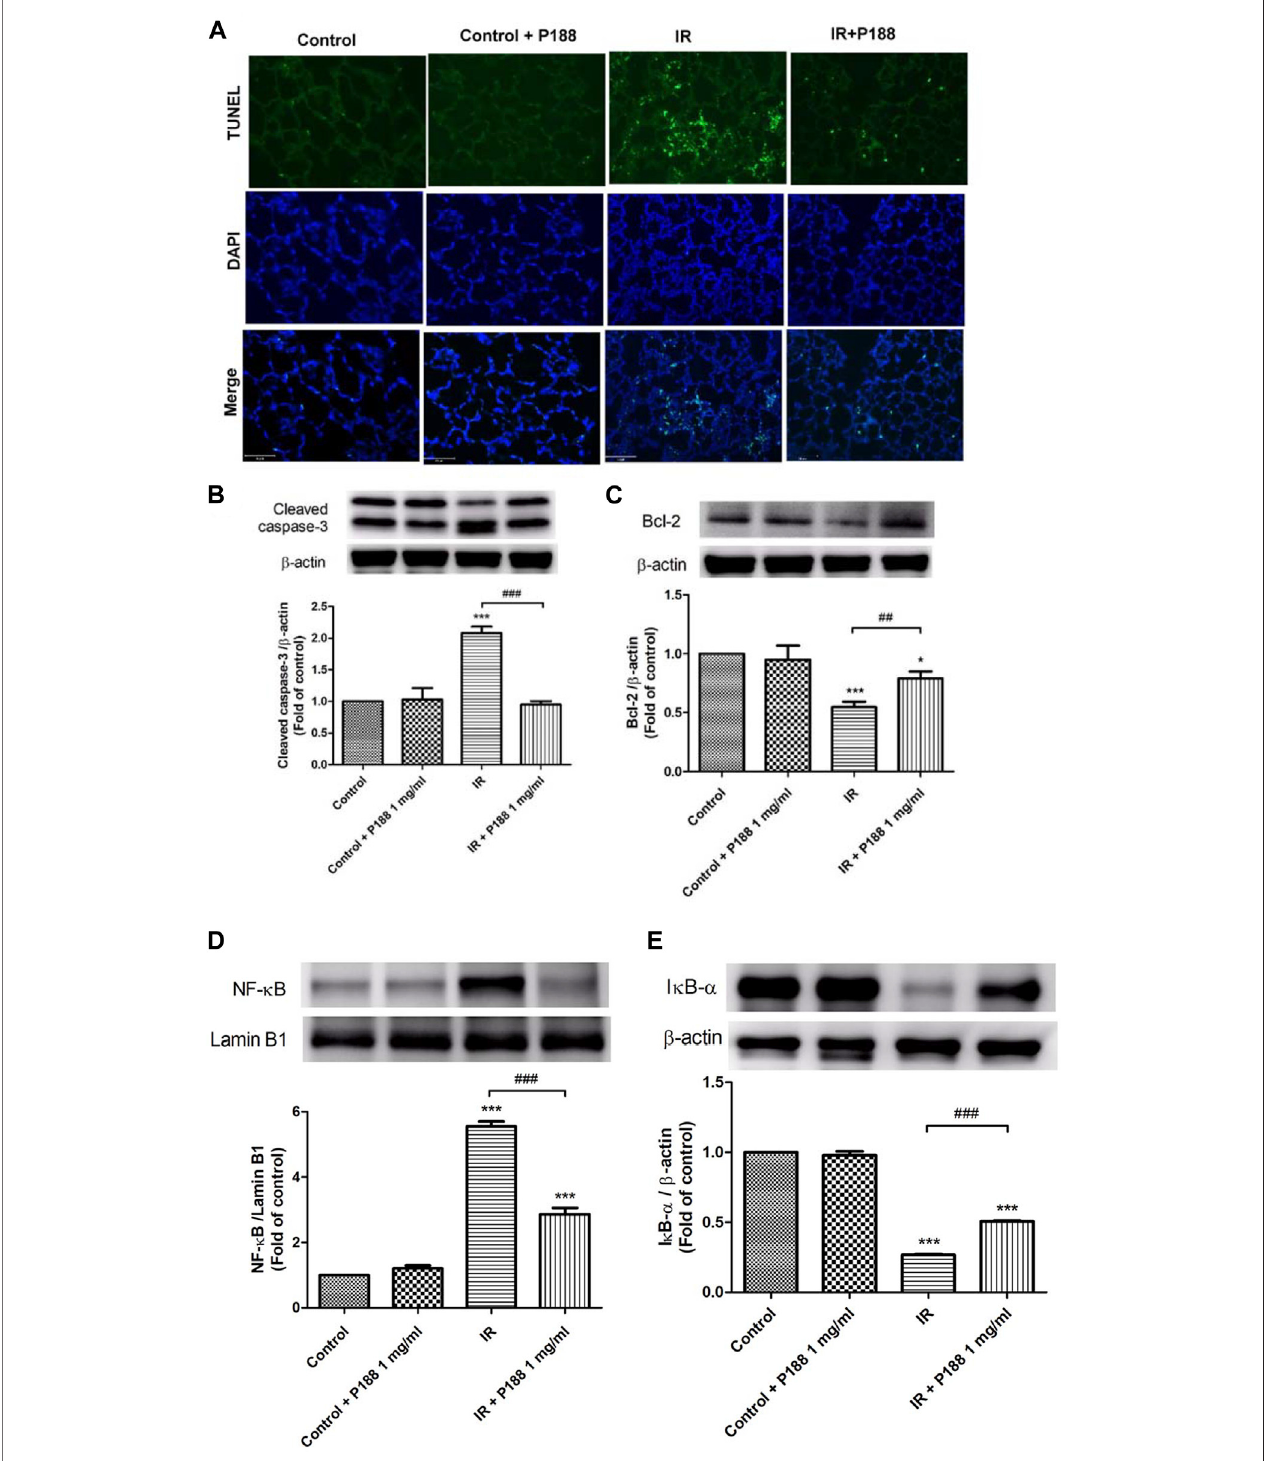
FIGURE5| EffectofP188onDNAfragmentation,expressionofcleavedcaspase-3andBcl-2,andNF- κ Bactivationduringischemia/reperfusion(IR)-inducedlung injury. (A) TUNEL assay of lung tissue. (B – E) Western blot analysis of cleaved caspase-3 (B) , Bcl-2 (C) , nuclear NF- κ B p65 (D) , and cytoplasmic I κ B- α (E) protein expressionsinlungtissues.LaminB1and β -actinwereusedasloadingcontrolsfornuclearandcytoplasmicproteins,respectively.Representativeblotsareshown.Data are mean ± SD (6 rats per group); * p < 0.05, *** p < 0.001 compared with the control group; ## p < 0.05, ### p < 0.001 compared with the IR group.